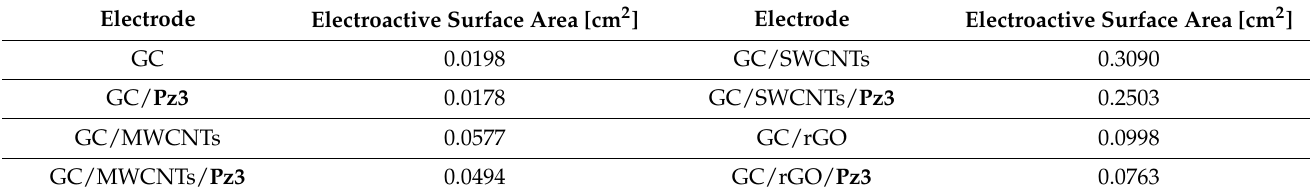
Table 2. Comparison of electroactive surface areas for the modified